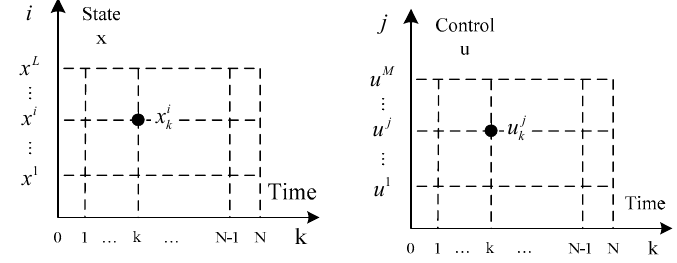
Figure 7. State and Control Input Discretization in Time and Space.